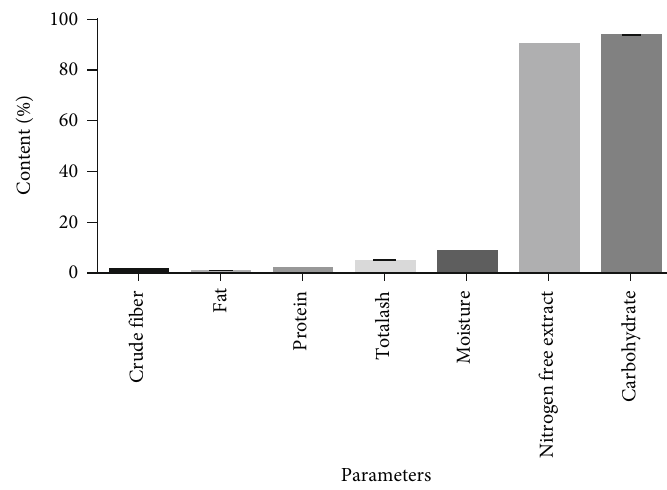
Figure 1: Proximate analysis of the HQCF sample (values are mean ± standard deviation , n = 3 ). Table 3: Microbial load and speci fi c media plate count of the various samples.